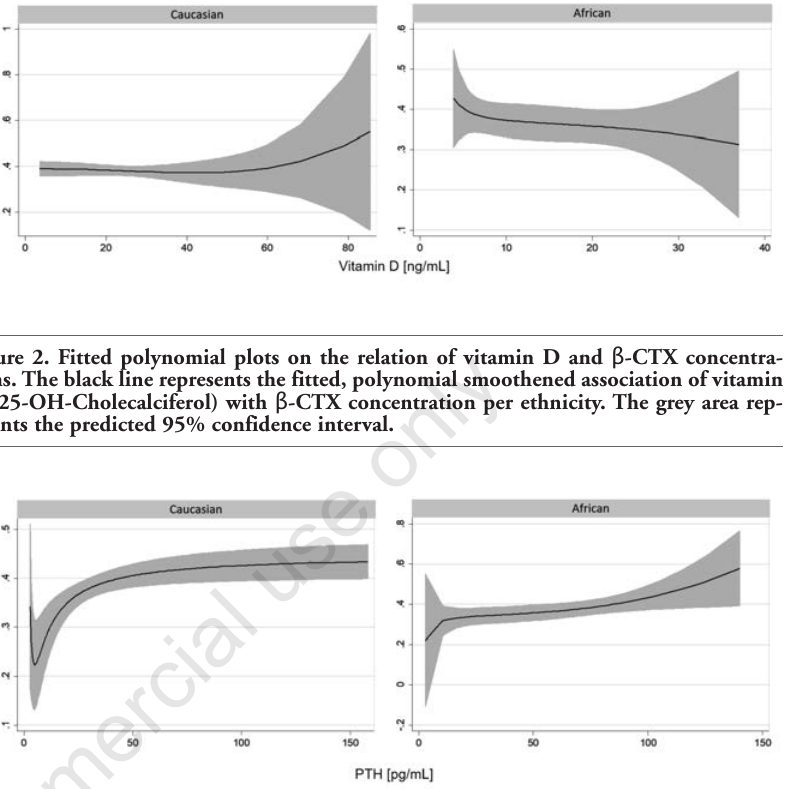
Figure 3. Fitted polynomial plots on the relation of PTH and black line represents the fitted, polynomial smoothened association of PTH with centration per ethnicity. The grey area represents the predicted 95% confidence interval.